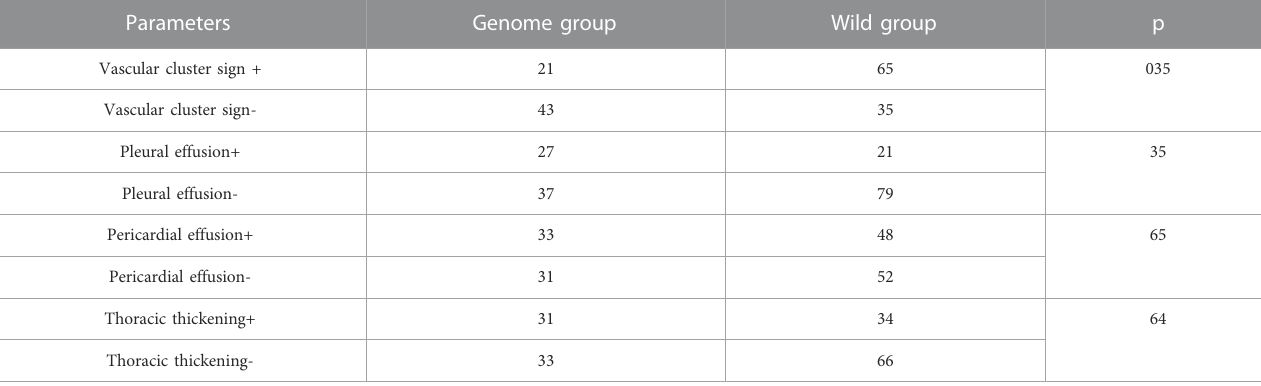
TABLE 4 CT presentation of adjacent structures and EGFR mutation status in LCA.